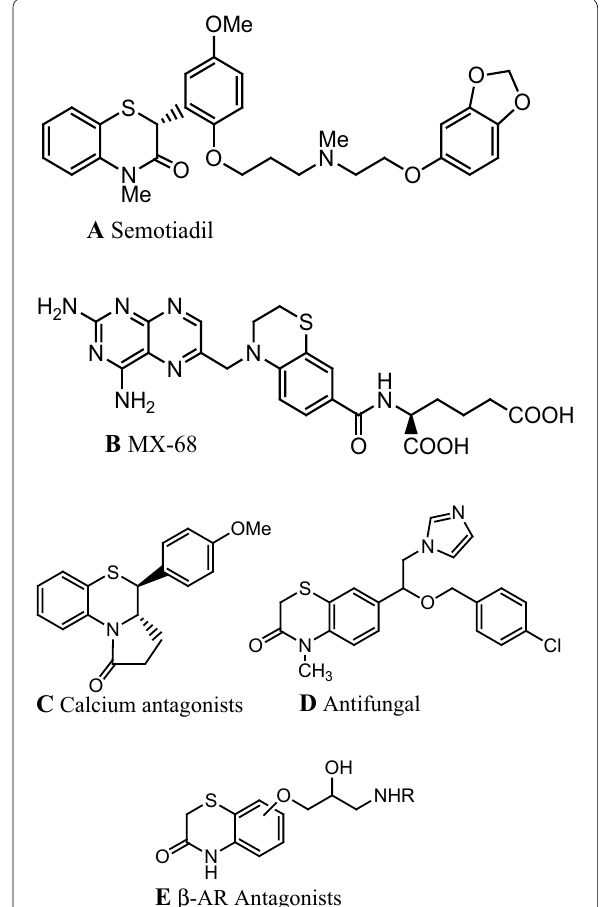
Fig. 1 Examples of bioactive molecules derived from